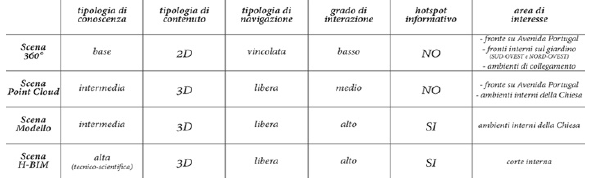
Figure 7: Definition of the technological system for the programming, execution and management of the VR experience.